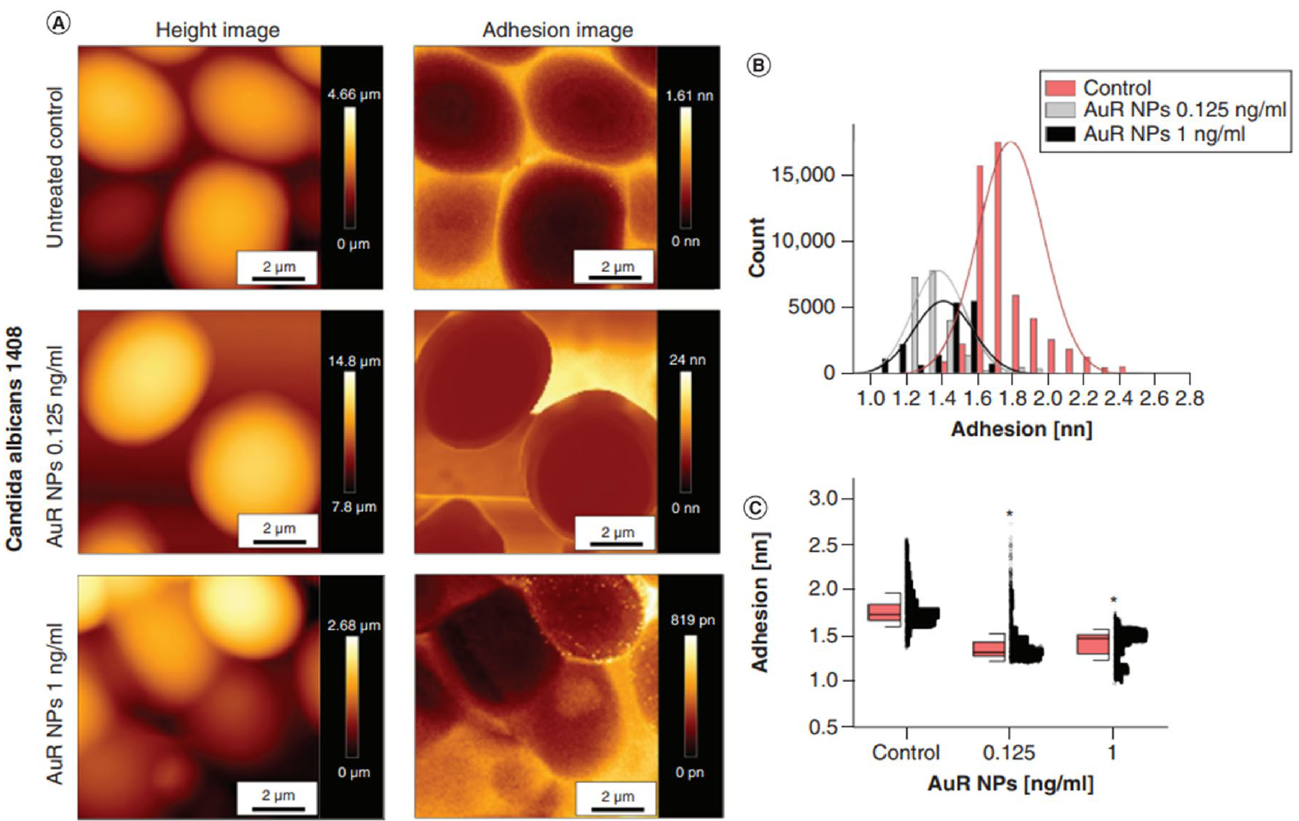
Figure 3. Height and adhesion images of Candida albicans strain 1408 using atomic force microscopy ( A ). Figures ( B , C ) show the adhesion distribution of Candida albicans strain treated with rod-shaped gold nanoparticles at doses of 0.125 ng/mL and 1 ng/mL compared to control cells. * indicates statistical significance ( p < 0.05) compared to untreated control. Reprinted with permission from [120]. 2022, Medical University of Bialystok.